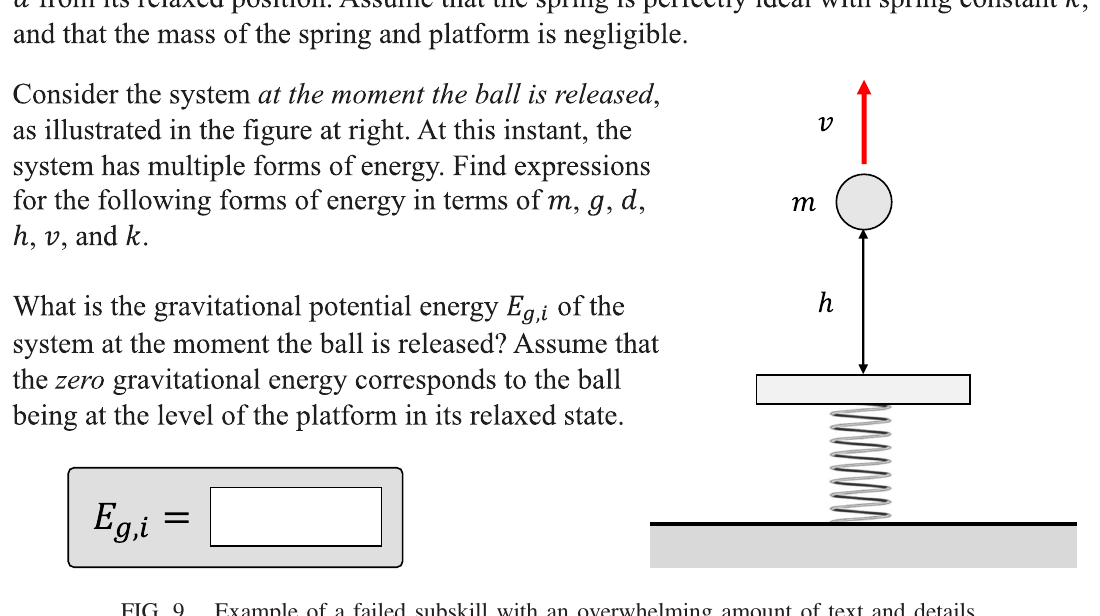
FIG. 9. Example of a failed subskill with an overwhelming amount of text and details.